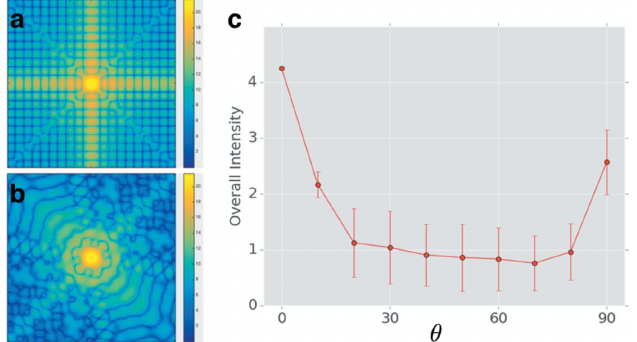
Figure 5 The dependence of the scattering pattern on orientation. ( a ) A simulated pattern for a tilting angle of 0 (cid:7) , the normal incidence case. ( b ) A typical scattering pattern when the tilting angle is 45 (cid:7) . There are two strong streaks when the incident beam is perpendicular to the particle surface as in panel (a), but the features for the scattering pattern at a tilting angle of 45 (cid:7) are less pronounced. ( c ) Total intensity plotted as a function of tilting angle. We simulated 500 patterns for each tilting angle. The overall intensity within the q range 0.44–0.89 nm (cid:6) 1 is calculated, showing that the overall intensity is lower for cases where the tilting angle is around 45 (cid:7) , while the standard deviations (error bars) for the intensity indicate larger fluctuations for the same group of